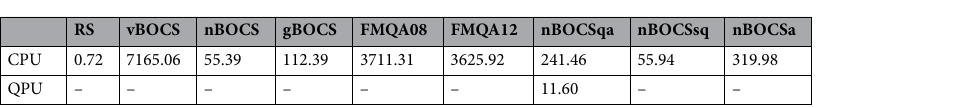
Table 2. Average execution time (s) per